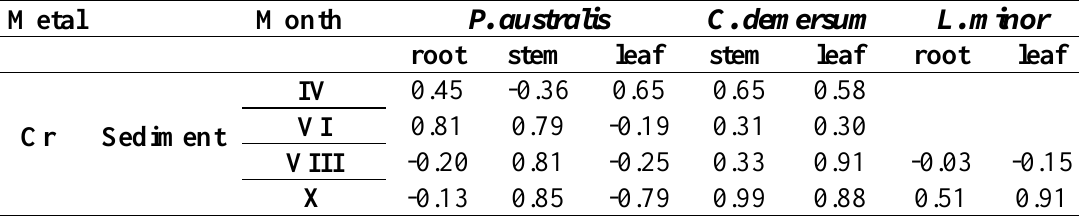
Table 6. Correlation coefficients, between the sediment and certain parts of the macrophytes Metal Month